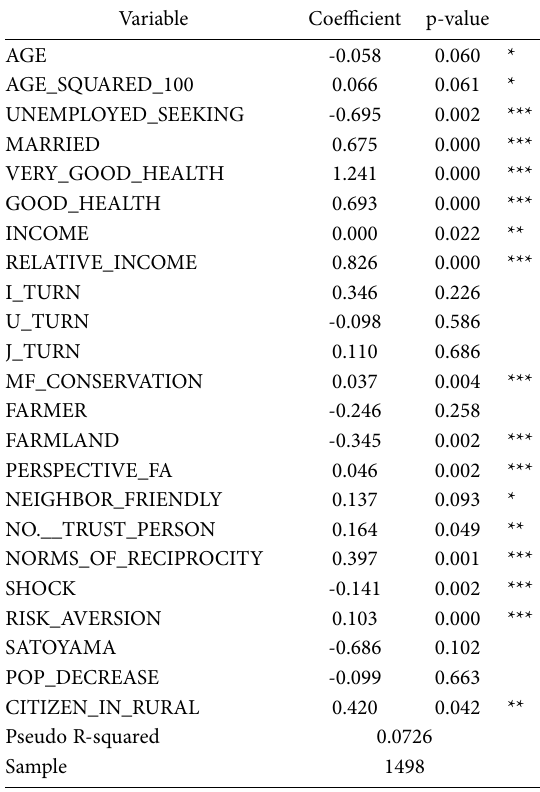
Table 3. Results of the ordered logit model across all respondents (Dependent variable: SWB).